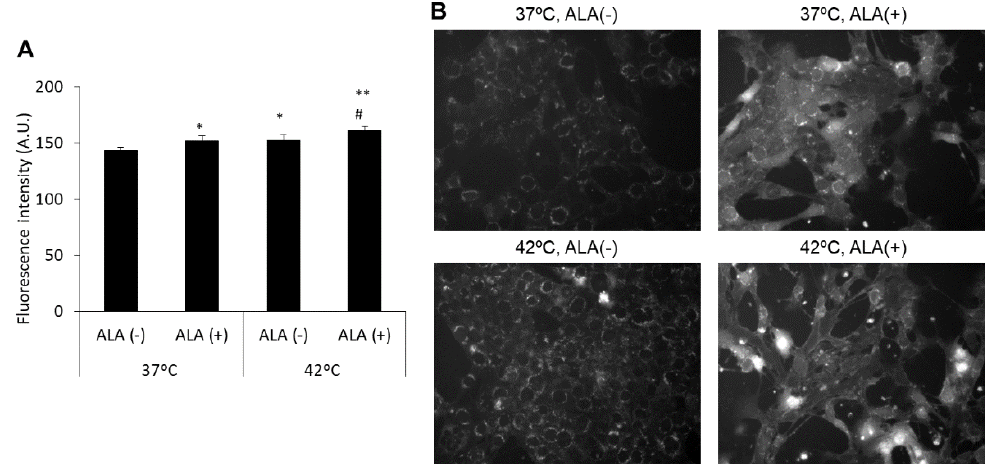
Figure 5. Fluorescence intensity of DOX. ( A ) Fluorescence intensity was measured using microplate reader. ( B ) Intracellular fluorescence intensity of DOX was observed under fluorescence micros- copy. Data are expressed as means ± SD ( n = 6). * p < 0.05 and ** p < 0.01 vs. 37 °C ALA ( − ). # p < 0.05 Data are expressed as means ± SD ( n = 6). * p < 0.05 and ** p < 0.01 vs. 37 ◦ C ALA ( − ). # p < 0.05 vs. vs. 37 °C ALA (+). Tukey’s post hoc test. 37 ◦ C ALA (+). Tukey’s post hoc